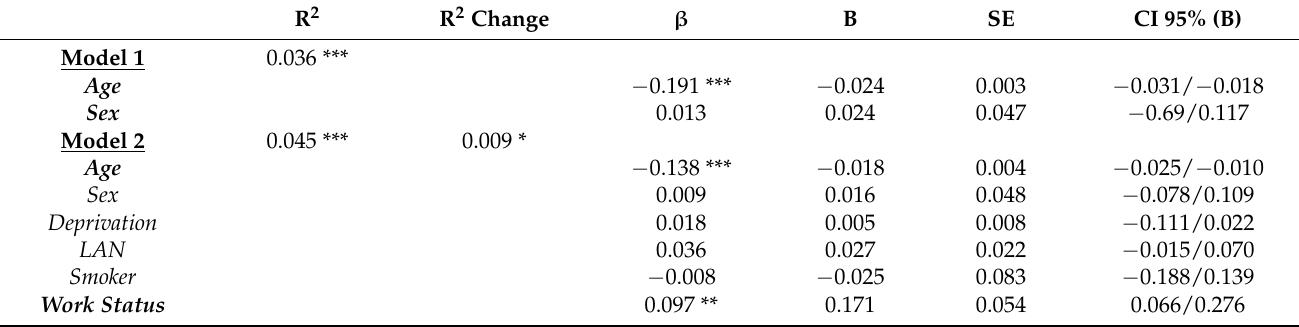
Table 3. Hierarchical Multiple Linear Regression Models with Absolute WD/WE Sleep Offset Difference as the Dependent Variable in a subset of participants with diabetes